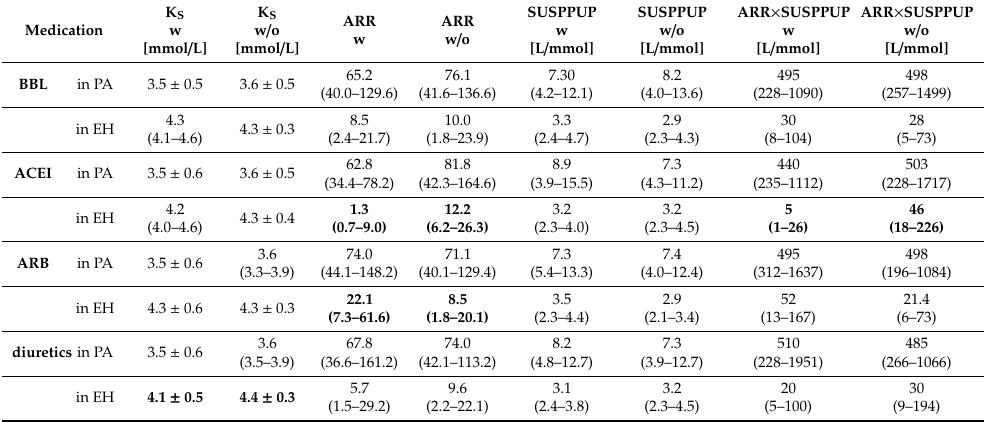
Results are presented as means ± standard deviation if normally distributed or medians (interquartile range). Figures in bold indicate statistical significance with a p -value of less than 0.05. Abbreviations: ACEI—angiotensin-converting enzymeinhibitors,ARB—angiotensinIItype1receptorblockers,ARR—aldosteronetoreninratio,BBL—betablockers, K S —serum potassium, SUSPPUP—serum sodium to urinary sodium divided by (serum potassium) 2 to urinary potassium ratio, w—with, w /